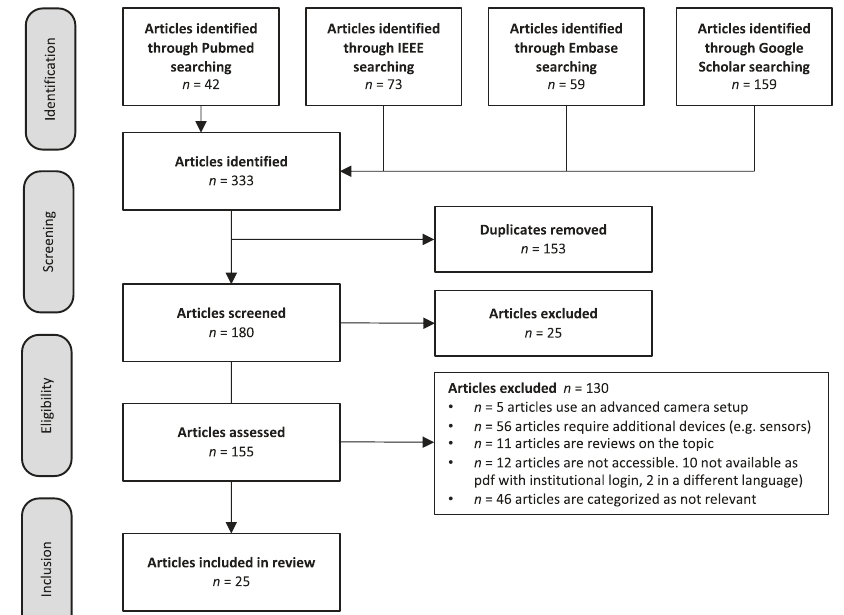
Fig. 1 Work fl ow of the study. Identi fi cation, screening, eligibility, and inclusion of